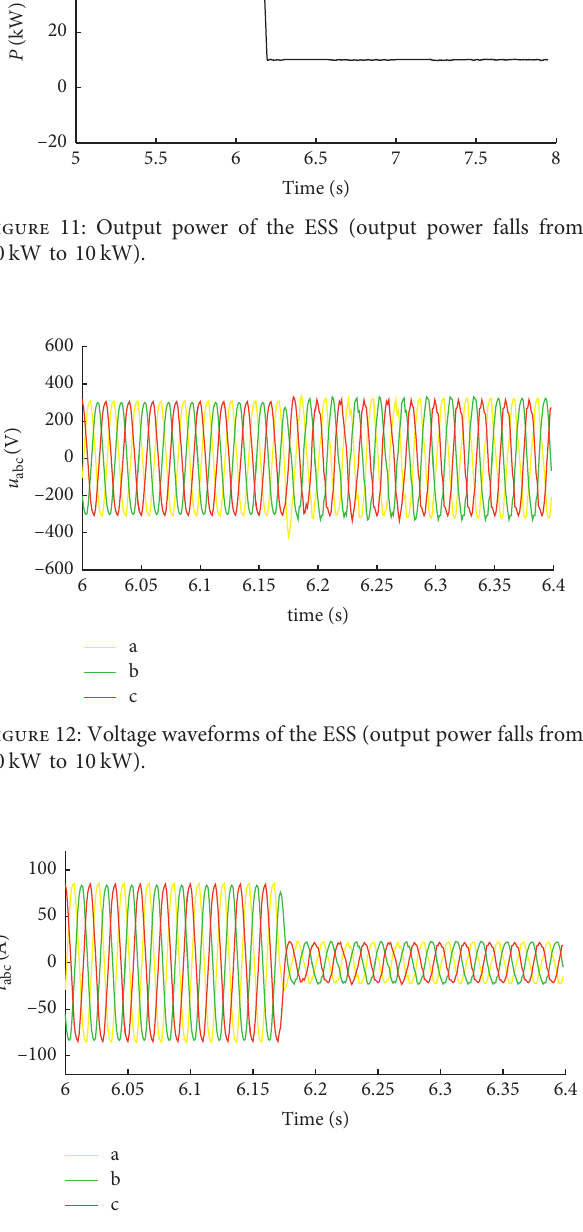
Figure 13: Current waveforms of the ESS (output power falls from 40kW to 10 kW).